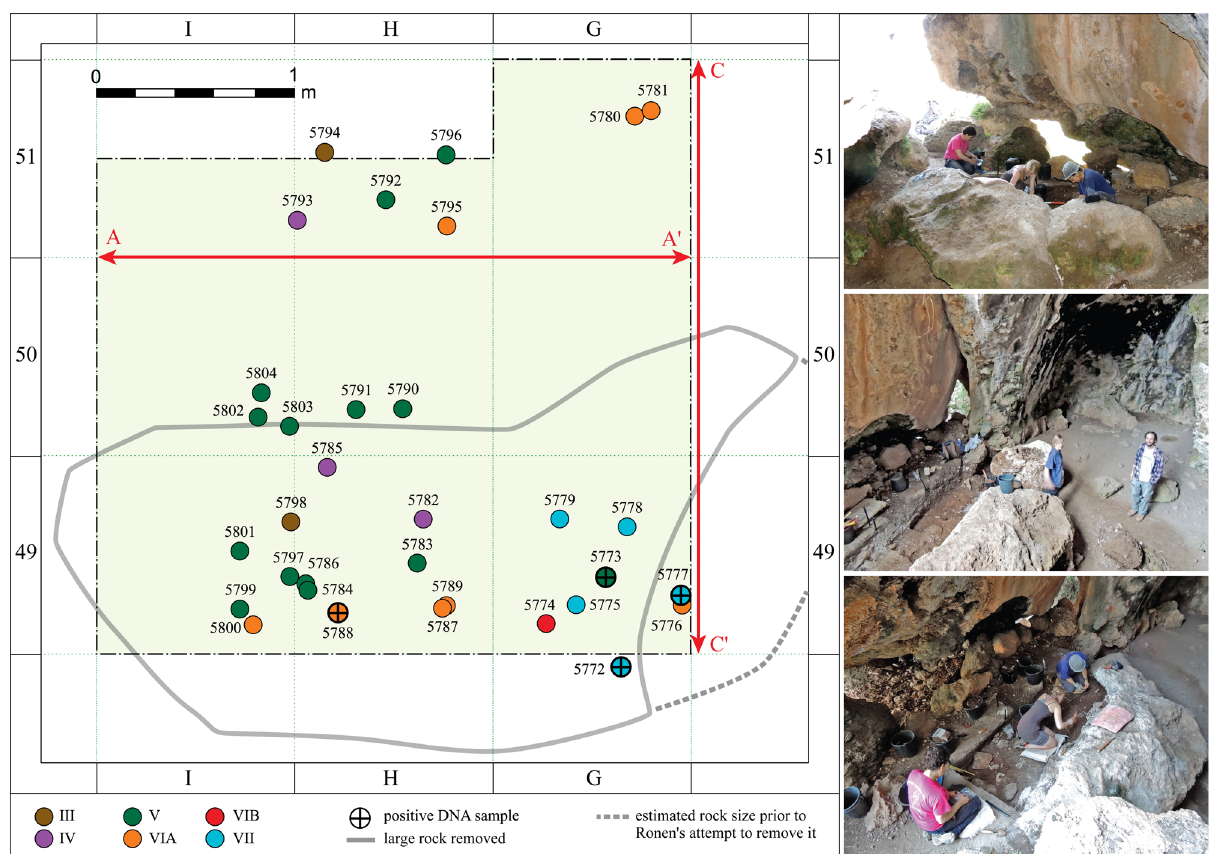
Figure 4. Locations of sediment samples collected for DNA analyses, shown on a plan of the Sefunim Cave excavation. Samples are color-coded according to the layer from which they originate, with a cross indicating samples that tested positive for the preservation of ancient mammalian mtDNA. The gray line depicts the outline of the boulder removed from the excavation area in 2017 prior to sampling. The dashed gray line shows the inferred extent of the rock before Ronen removed part of it. The red arrows represent the two main sections shown in Fig. 3. The photographs on the right document the gradual removal of the limestone boulder before its complete removal. The distribution map was generated with ArcGIS Desktop 10.6.1.9270 (https:// deskt op. arcgis. com); photographs are by A.